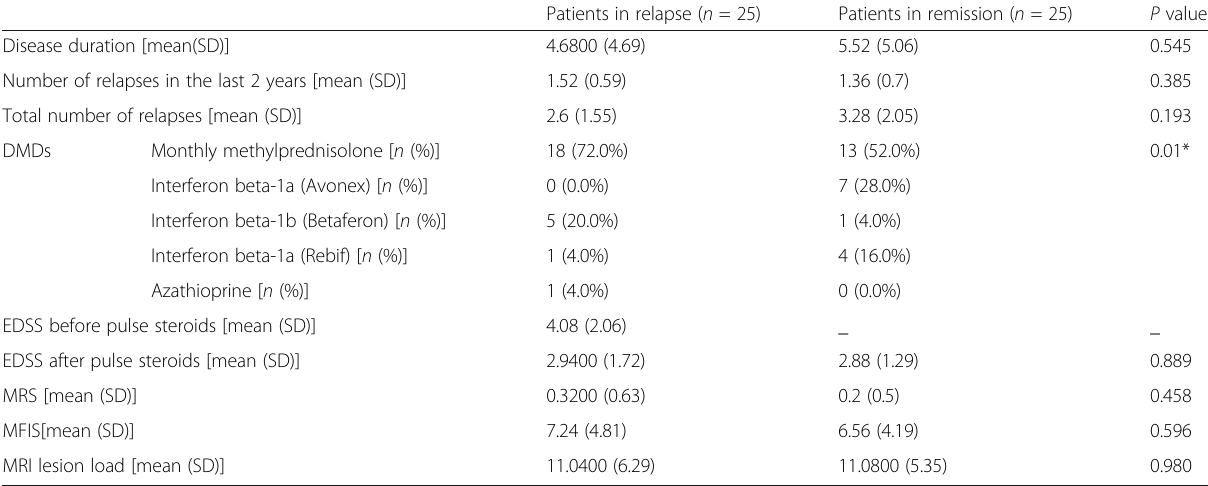
Patients in relapse ( n = 25) Patients in remission ( n = 25) P value